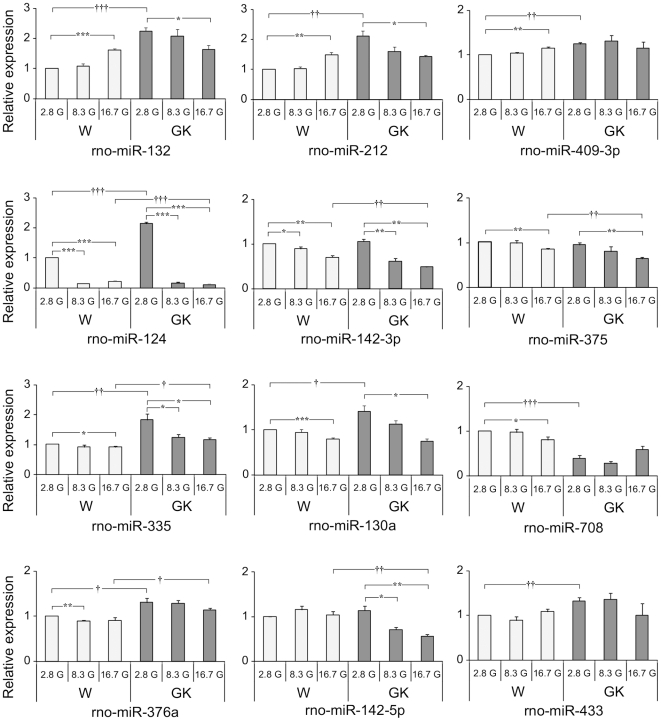
Glucose-dependence of miRNA levels after 24 h incubation at 2.8 mM, 8.3 mM and 16.7 mM glucose.Three general trends of miRNA expression trajectories were observed for Wistar islets at 2.8G vs 16.7G: i) increased expression as exhibited by rno-miR-132, rno-miR-212 and rno-miR-409-3p, ii) decreased expression as in the case of rno-miR-124, rno-miR-142-3p, rno-miR-375, rno-miR-335, rno-miR-130a and rno-miR-708 and, iii) no change as seen in rno-miR-376a, rno-miR-142-5p and rno-miR-433. For GK islet expression, the miRNAs generally exhibited expression trajectories aimed at attaining Wistar islet levels. Data analysis and presentation are as described for Figure 3.